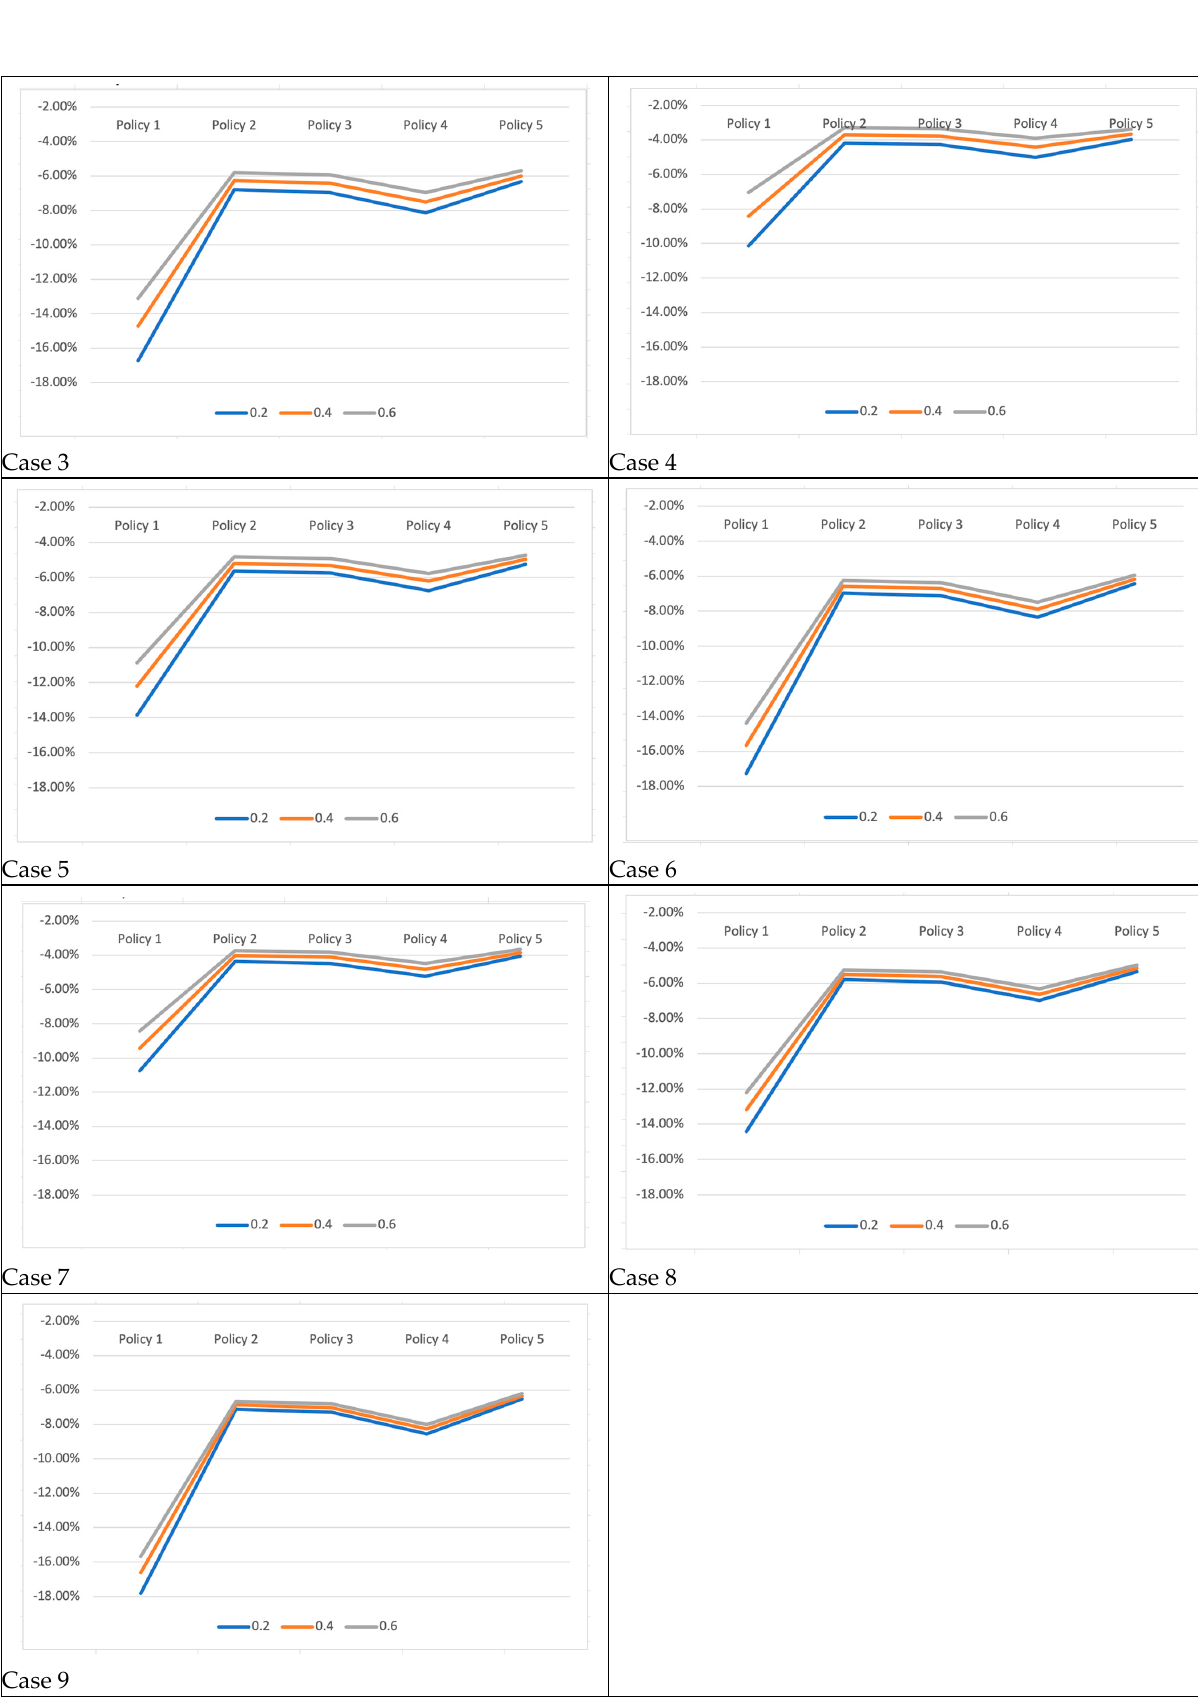
Figure 2. Energy consumption